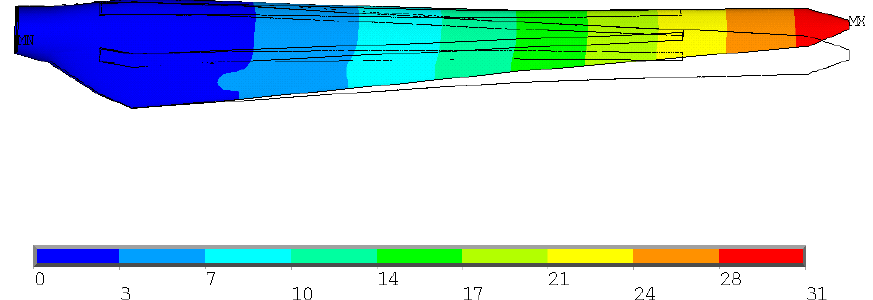
Figure 19. Total deformation of the RÜZGEM blade model vs. undeformed model under 100% extreme edgewise loading condition (scale factor: × 8).